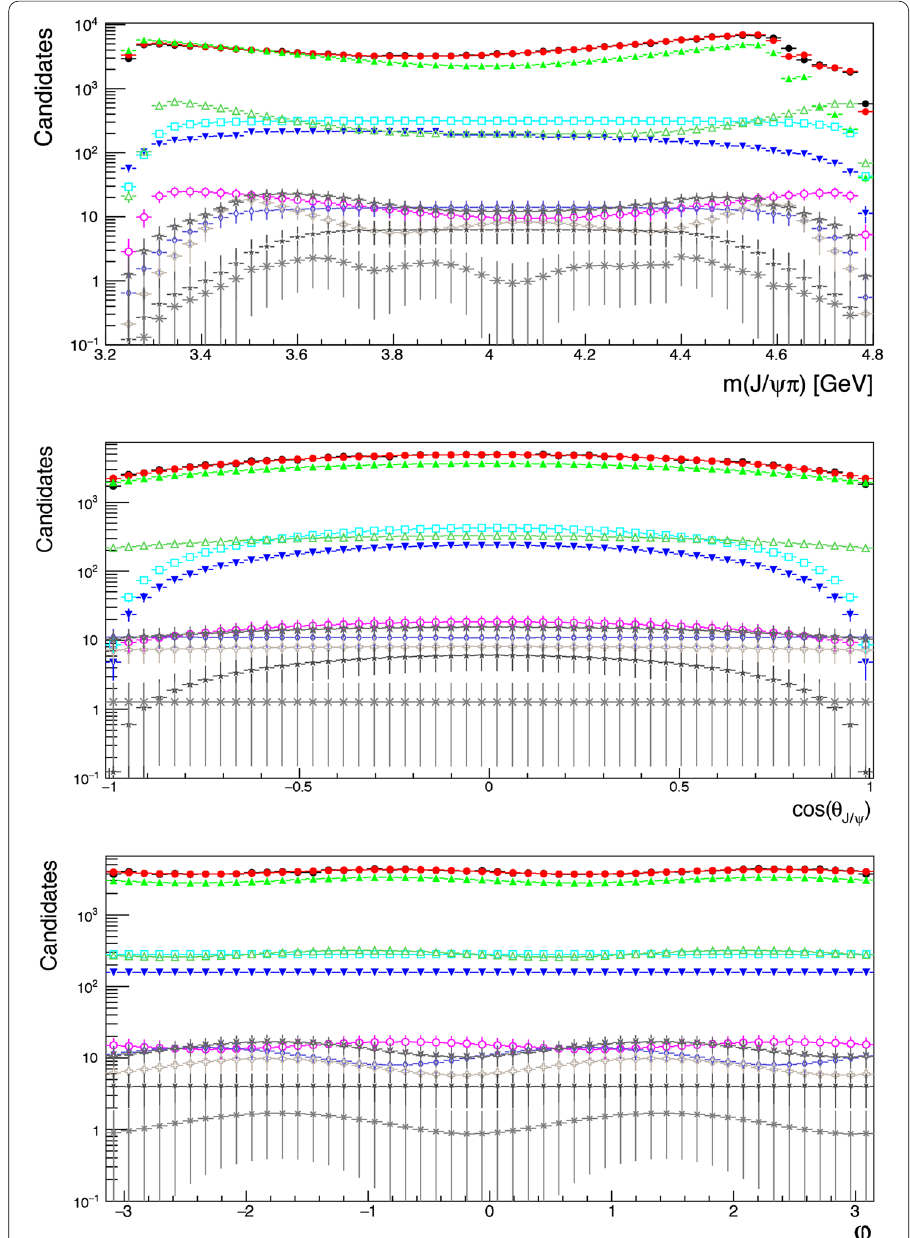
Fig. 4 Projections of the other three variables: (from top to bottom) m J /ψπ , cos θ J /ψ , and ϕ of the 4D dataset generated according to an ideal signal model (black points with error bars). The fit result (red points with error bars) is superimposed along with the individual fit components corresponding to different K ∗